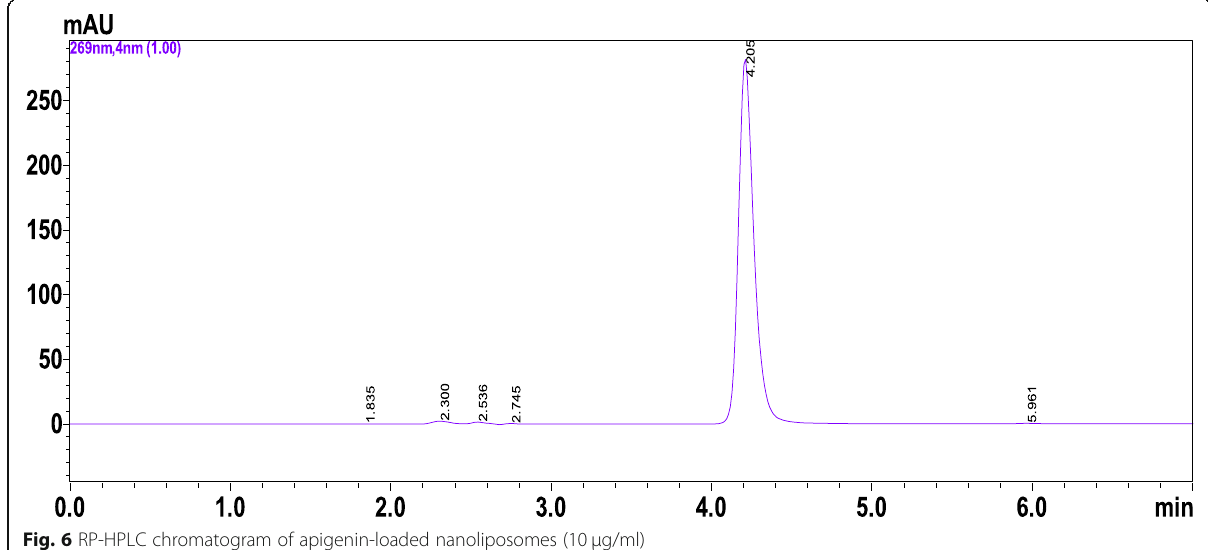
Fig. 6 RP-HPLC chromatogram of apigenin-loaded nanoliposomes (10 μ